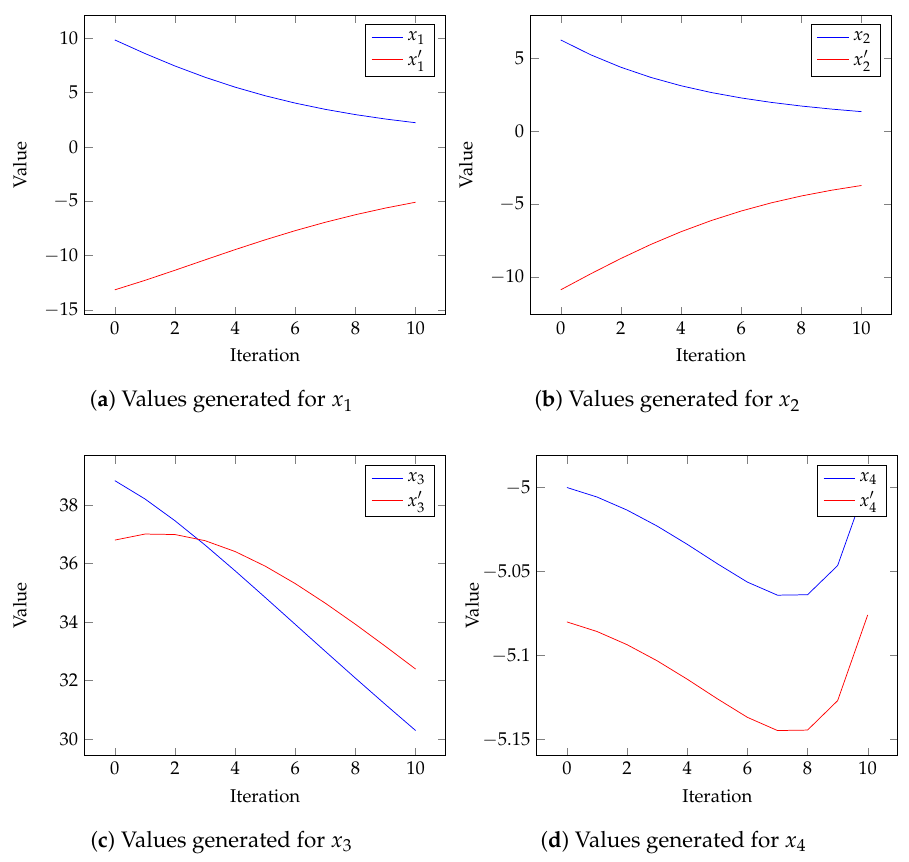
Figure 13. Values generated with initial conditions for x 1 , x 2 , x 3 , and x 4